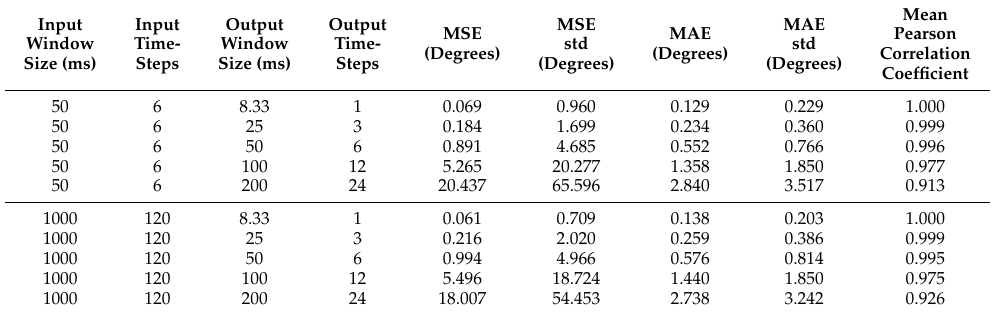
Table 3. Performance of CNN in forecasting gait trajectories for varying input and output window sizes.